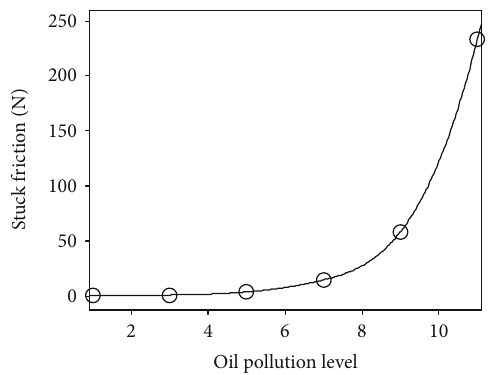
Figure 21: The relation curve between clamping friction force and the particles diameter.